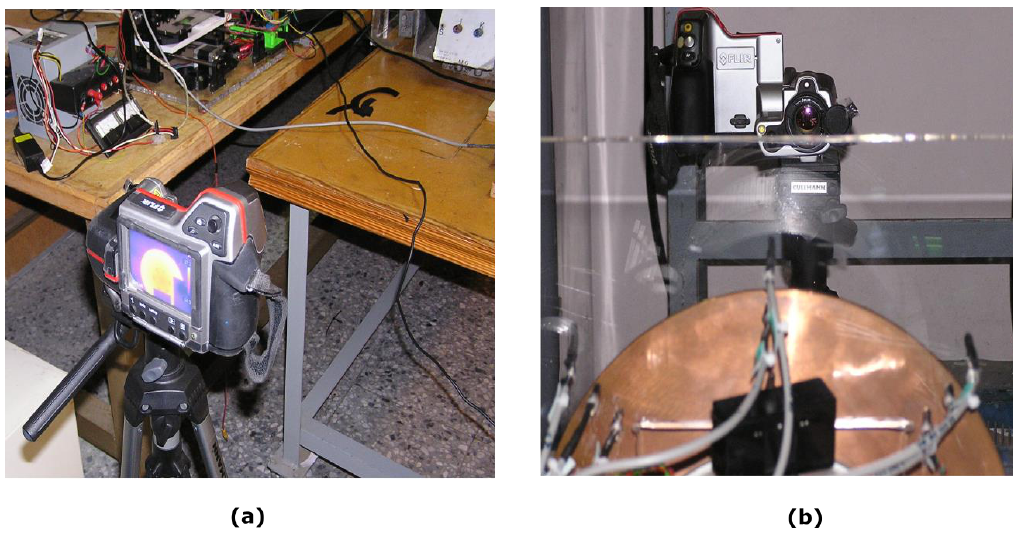
Figure 22. ( a ) Rear view of the FLIR T425 camera; ( b ) Front view of the FLIR T425 camera.